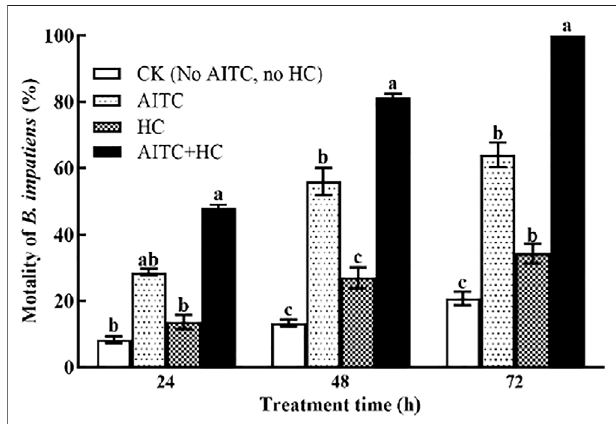
FIGURE5| Changesinmortalityof B.impatiens inthreetreatmenthours under ambient CO 2 or/and high CO 2 conditions with and without AITC fumigation. CK: no AITC fumigation under ambient CO 2 condition; AF: AITC fumigation; HC: high CO 2 stress; AF + HC: AITC fumigation under high CO 2 condition. Data represent mean ± SD of three replicates. Different lower- case letters indicate statistically signi fi cant difference between sub-lethal concentrations by Tukey ’ s test ( p <